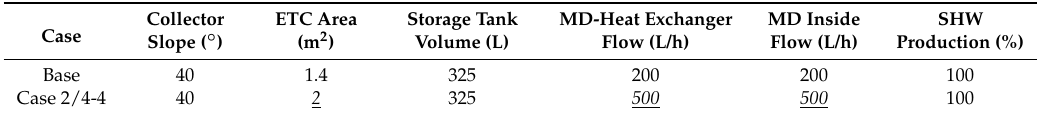
Table 9. Best case design (maximum MD